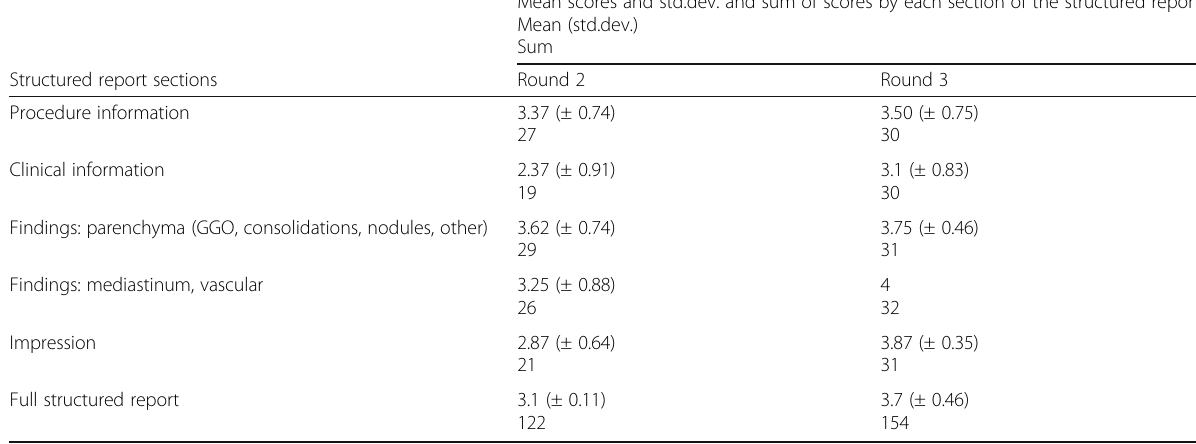
Table 1 Mean scores and sum of scores of panelists